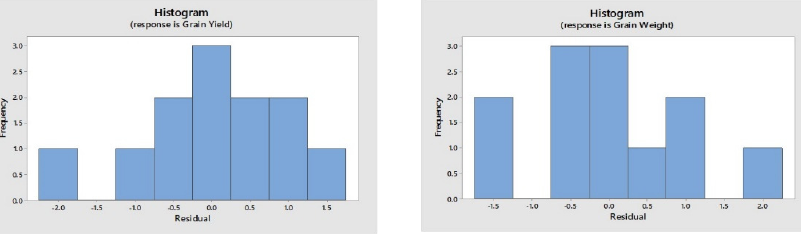
Figure 3. Histogram of the harvesting parameters.